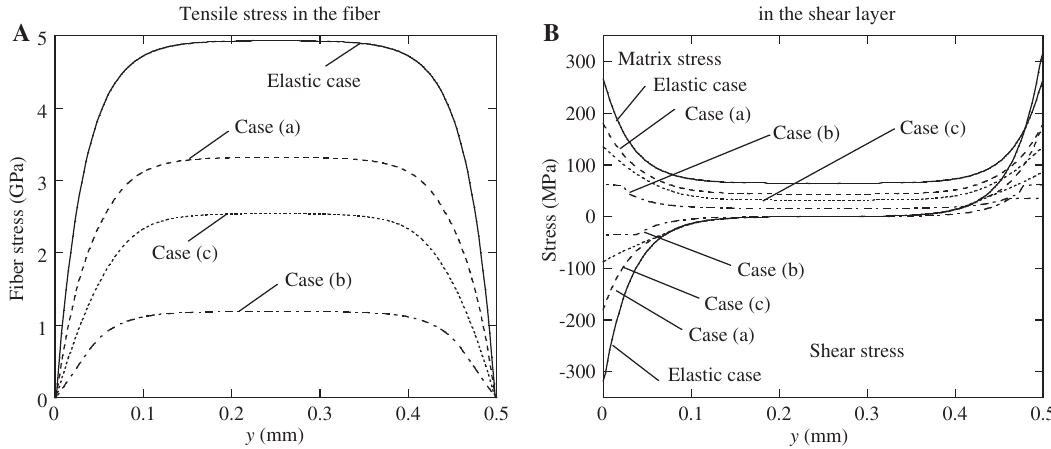
Figure 8 Comparison of analytical results. Effect of matrix and shear layer properties on the stress